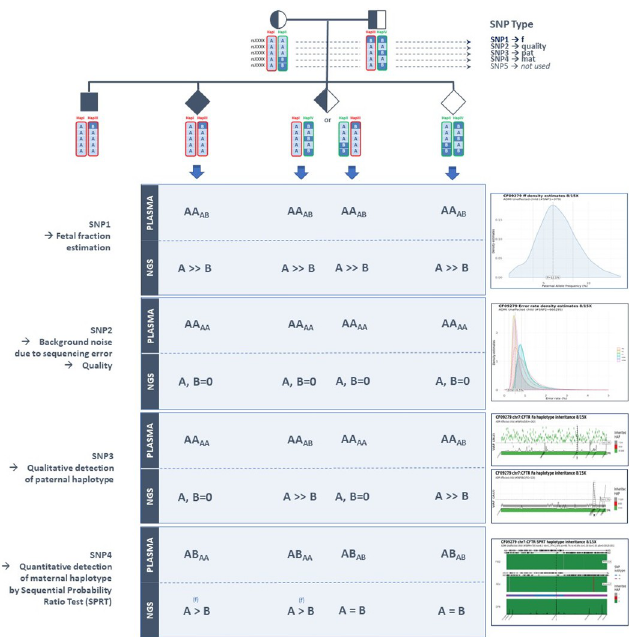
Fig 2. Noninvasive fetal genomic analysis from maternal plasma DNA. In the test cohort, the proband’s gDNA is used to identify each parental haplotypes. HapI is the maternal at-risk haplotype; HapII is the maternal non-at-risk haplotype, HapIII is the paternal at-risk haplotype and HapIV is the paternal non-at-risk haplotype. A family-specific pile-up was generated from cfDNA sequencing data, by counting the number of reads for each base. Each SNP of the pile-up can be categorized based on parental inheritance. SNP1 (mother AA and father BB) and SNP2 (mother AA and father AA) allow the basic parameters for maternal plasma DNA sequencing to be established, including fetal fraction and sequencing error rate estimations. SNP3 (mother AA and father AB) allow qualitative paternal haplotype transmission determination. SNP4 (mother AB and father AA) allow quantitative maternal haplotype transmission determination, thanks the tracking of fetal inheritance of a haplotype block close to the mutation carried by the mother. SNP5 were not analyzed in this study.